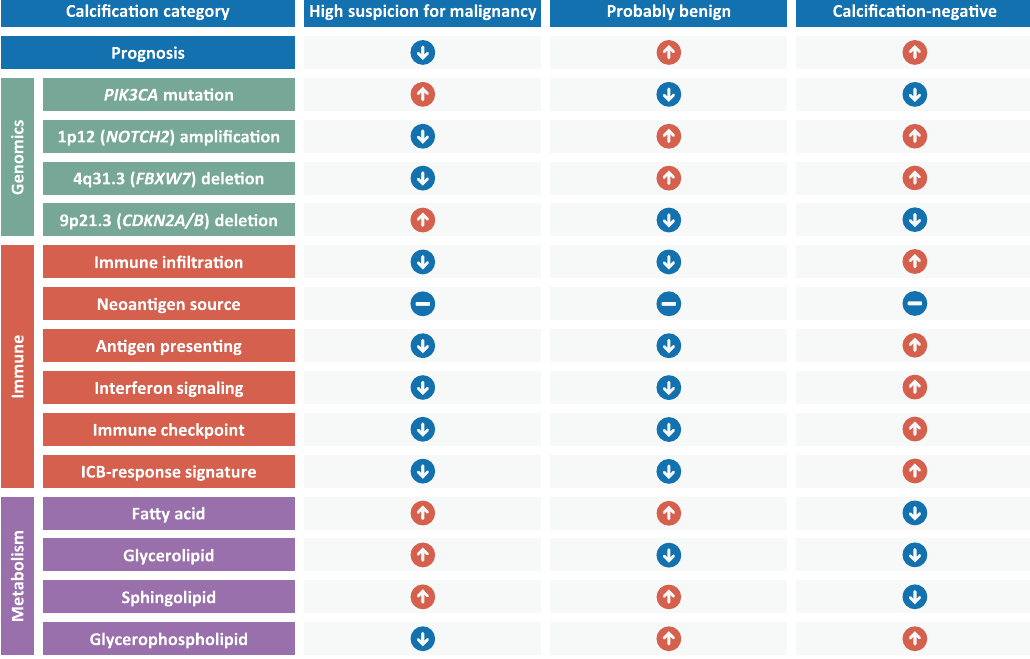
Fig. 5 Summary of the molecular characteristics across TNBC with different calci fi cation statuses. Red (blue) circles with white up (down) arrows denote increased (decreased) levels or potentially better (worse) response, while the blue circles with horizontal bars indicate no signi fi cant